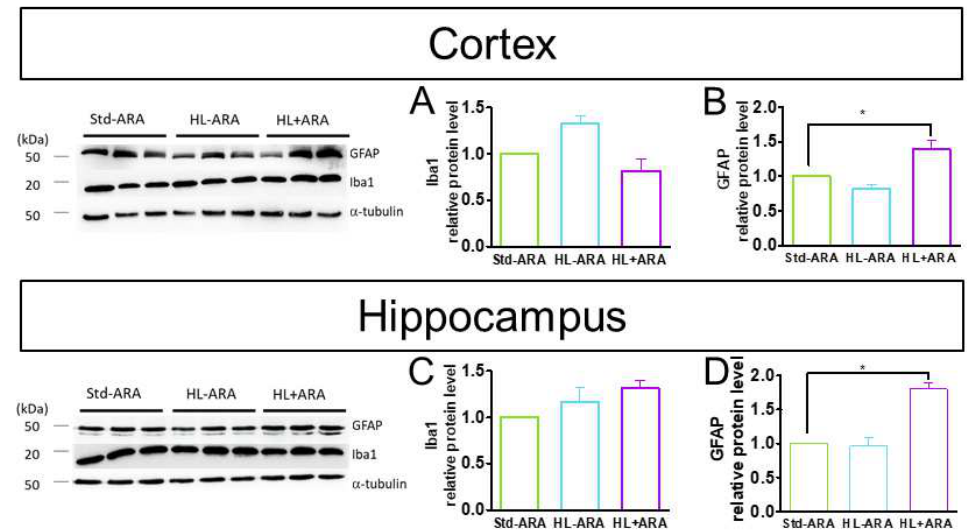
Figure 6. Western blot analysis of Iba1, GFAP, and α-tubulin in the cortex ( A , B ) and hippocampus ( C , D ). The protein levels were quantified by densitometry, normalized to the α-tubulin level, and expressed as a relative protein level. Data are represented as the mean ± standard error of the mean (SEM). n = 3 mouse per diet group. * p < 0.05 compared with the standard diet. Data analyzed by one-way ANOVA test and Bonferroni’s multiple comparisons test for post hoc analysis. The increased expression of GFAP in the hippocampus of the HL + ARA diet group chemistry results (Figure 7).